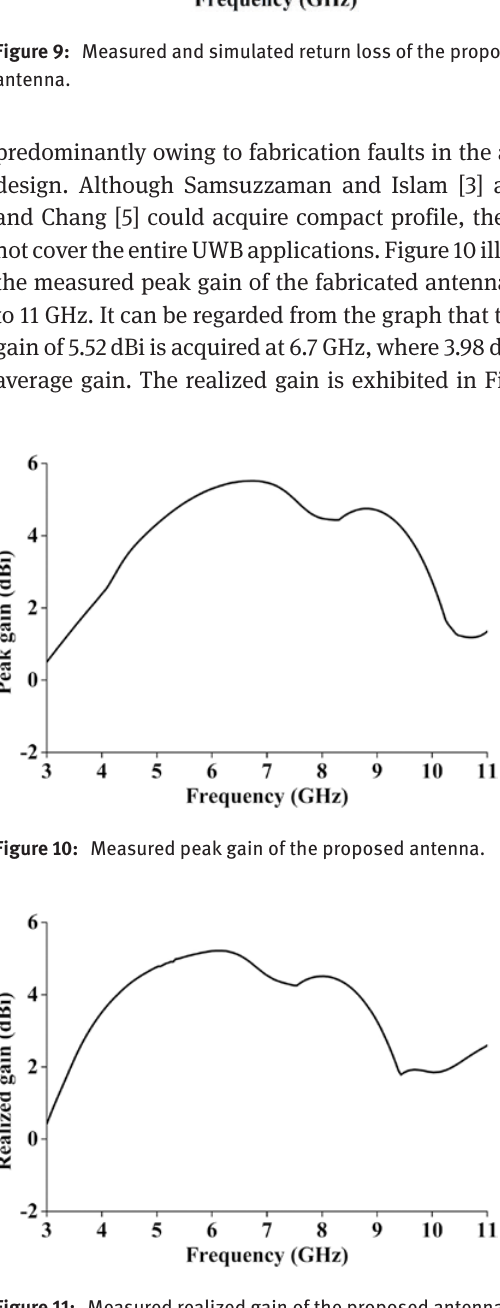
Figure 8: Photograph of the fabricated prototype.